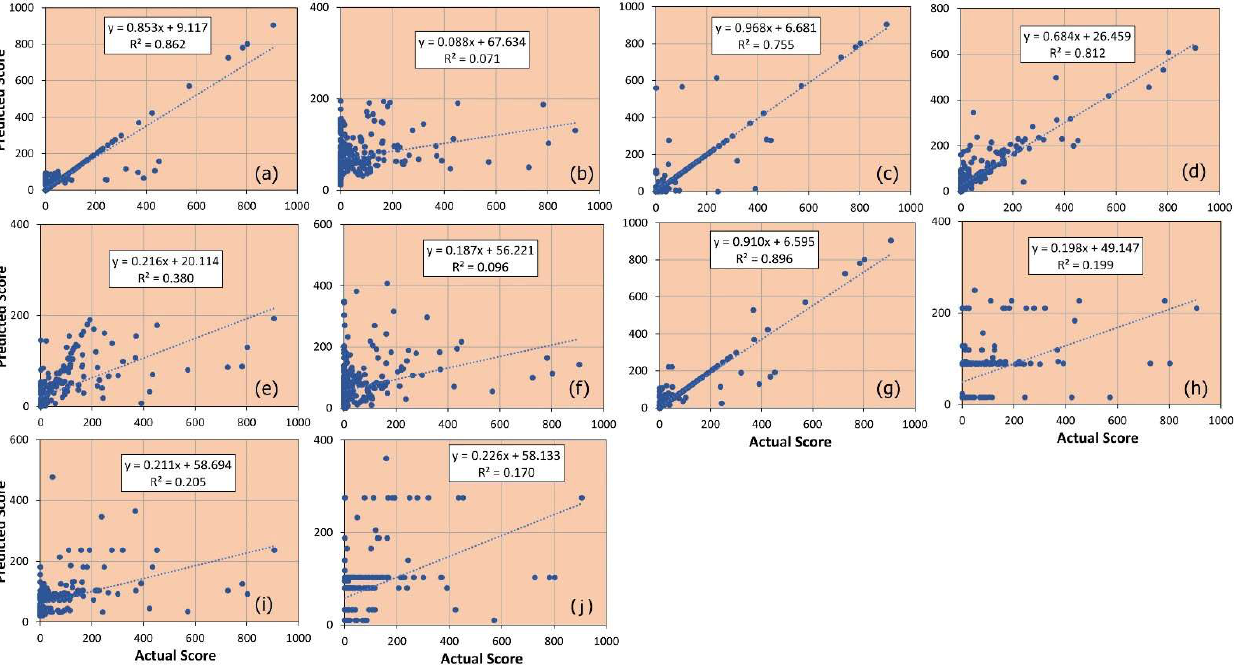
Figure A2. The features’ importance: ( a ) Pearson’s correlation, ( b ) Boruta, and ( c ) Random Forest.